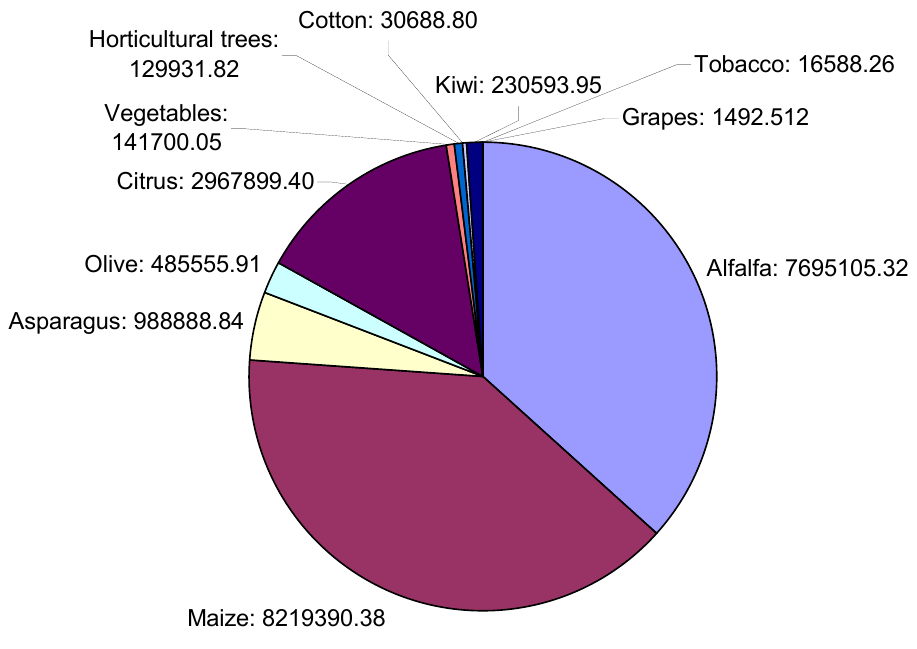
Figure 11. Water volume (m 3 yr -1 ) that is required per crop in Aitolikon